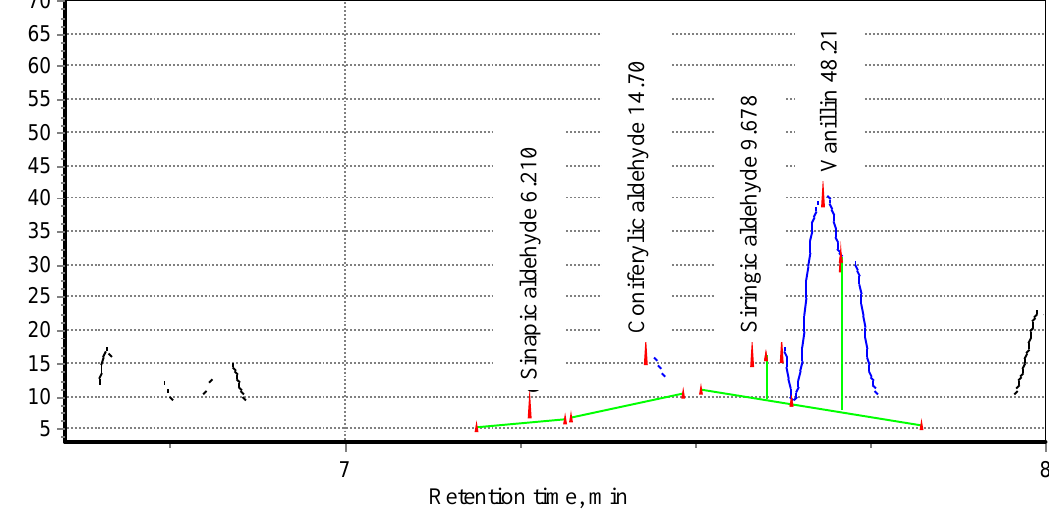
Fig. 2. Electrophoregram of aqueous-alcoholic extract of wild camomile flowers (2-time dilution).